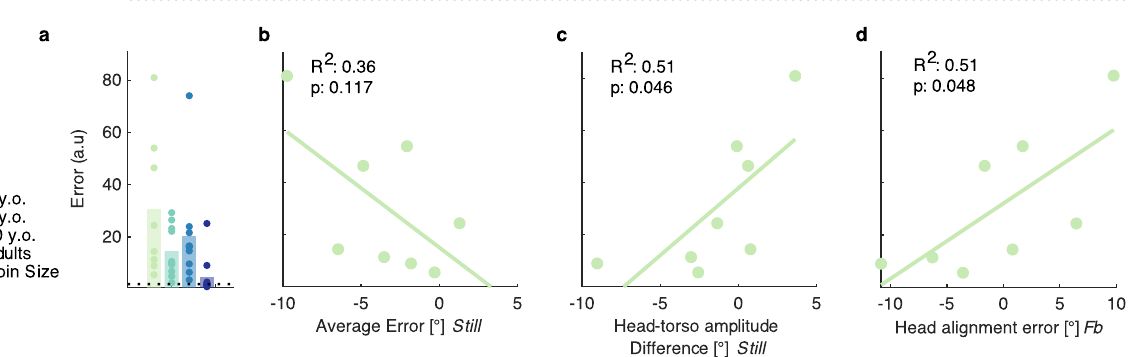
Figure 6. Prediction of flight game steering performance from JAR test. ( a ) Performance during a unique torso-controlled session of the flight game. ( b–d ) Regression analyses on the data of the 6-year-olds, recorded during torso trials of the JAR test. ( b ) Signed error at final orientation (see Fig. 5a). ( c ) Difference between final head orientation and target orientation (see Fig. 5f). ( d ) Difference between final head orientation and target orientation (see Fig. 5g). Dots represent the average error for each individual participant, bars the average across participants. N = 8 (6 y.o.), 10 (8 y.o.), 10 (10 y.o.), 10 (adults). Fb: Feedback, No Fb: No feedback; see text for description of the